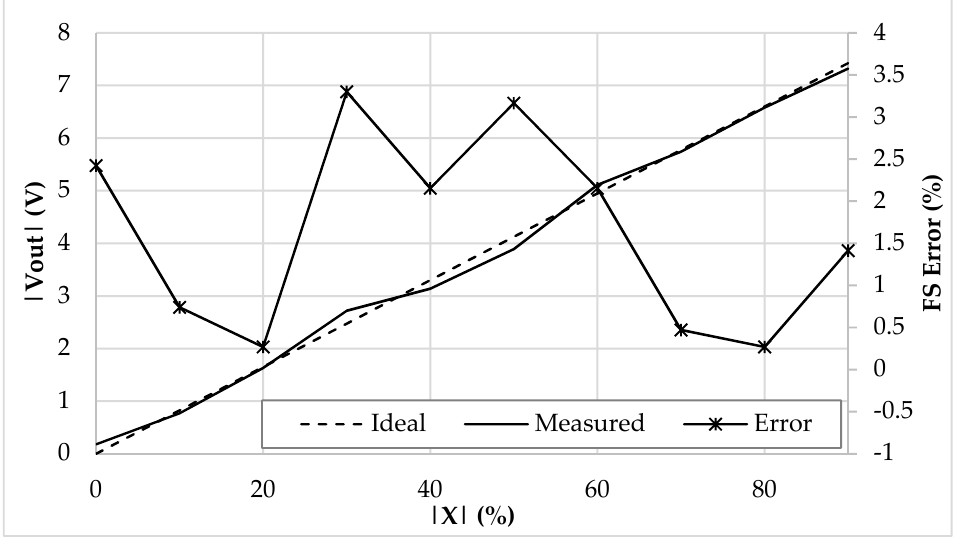
Figure 14. DC characteristic ( | V out | vs. | x | ) and full-scale error (%) of the prototyped interface with a 10 pF sensor baseline.